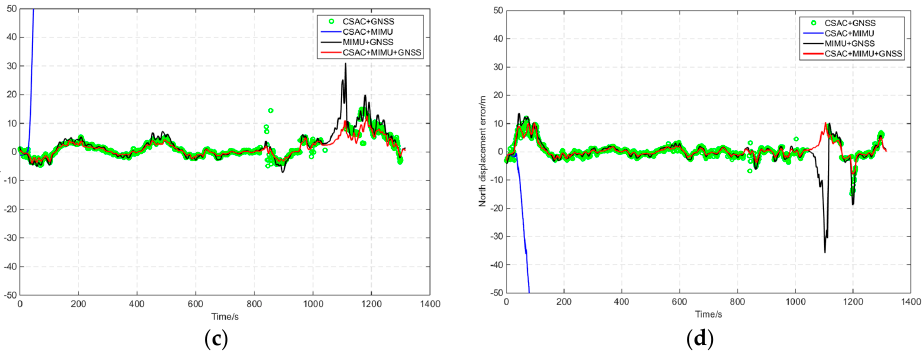
Figure 14. Displacements and errors for the harsh route. ( a ) East displacement with time of GI7660; ( b ) North displacement with time of GI7660; ( c ) East displacement error with time; ( d ) North displacement error with time. Table 7. Comparison of the navigation results for the harsh route.